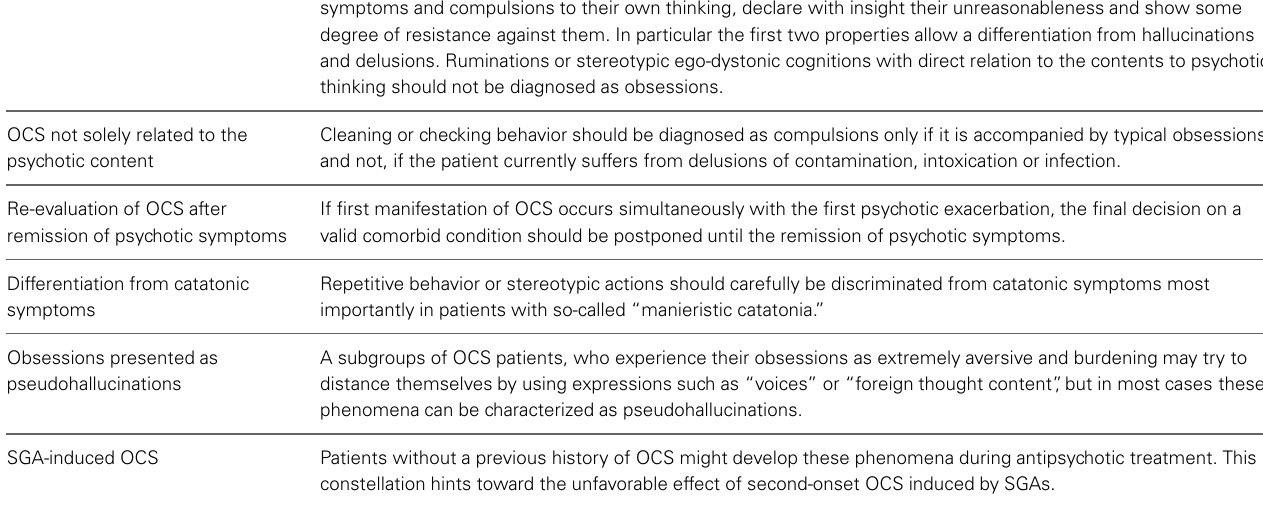
Table 1 | Identification of obsessive-compulsive symptoms in